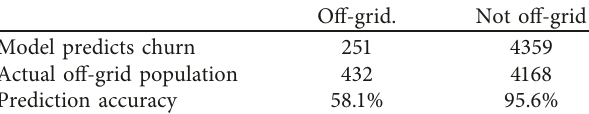
Table 5: Logistic regression prediction accuracy.